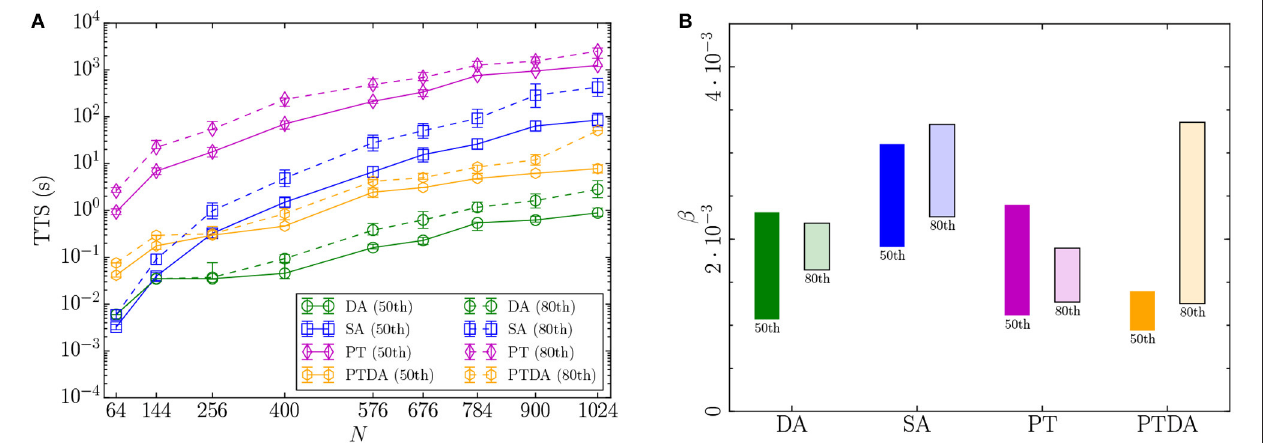
FIGURE 8 | (A) Mean, 5th, and 95th percentiles of the TTS distributions (TTS 50 and TTS 80 ) for fully connected spin-glass problems with Gaussian disorder. For some problem sizes, the percentiles are smaller than the symbols. (B) The 90% confidence interval of the estimated scaling exponent β based on the mean of the TTS 50 and TTS 80 for the SK-Gaussian problem class. The label below each rectangle represents the TTS percentile on which the confidence interval is based. For each algorithm, the five largest problem sizes have been used to estimate the scaling exponent by fitting a linear model to log 10 TTS. The R 2 of the fitted model is greater than or slightly lower than 90 % for each algorithm.